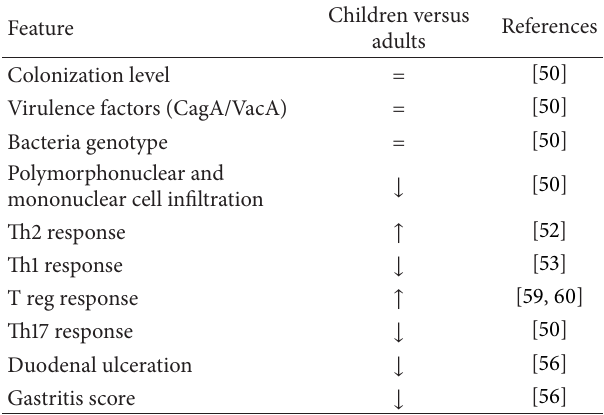
Table 1: Children and adults H. pylori -related immunopathological